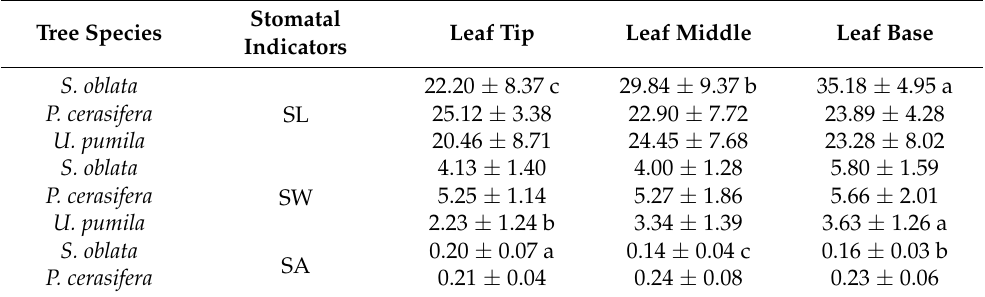
Table 7. Stomatal aperture characteristics of all three tree species in different leaf zones (9 September). Within each treatment and date, statistical differences between 10 days and 40 days ( p < 0.05) are denoted with lower case letters a, b, and c. Data represent means ± SE ( n =